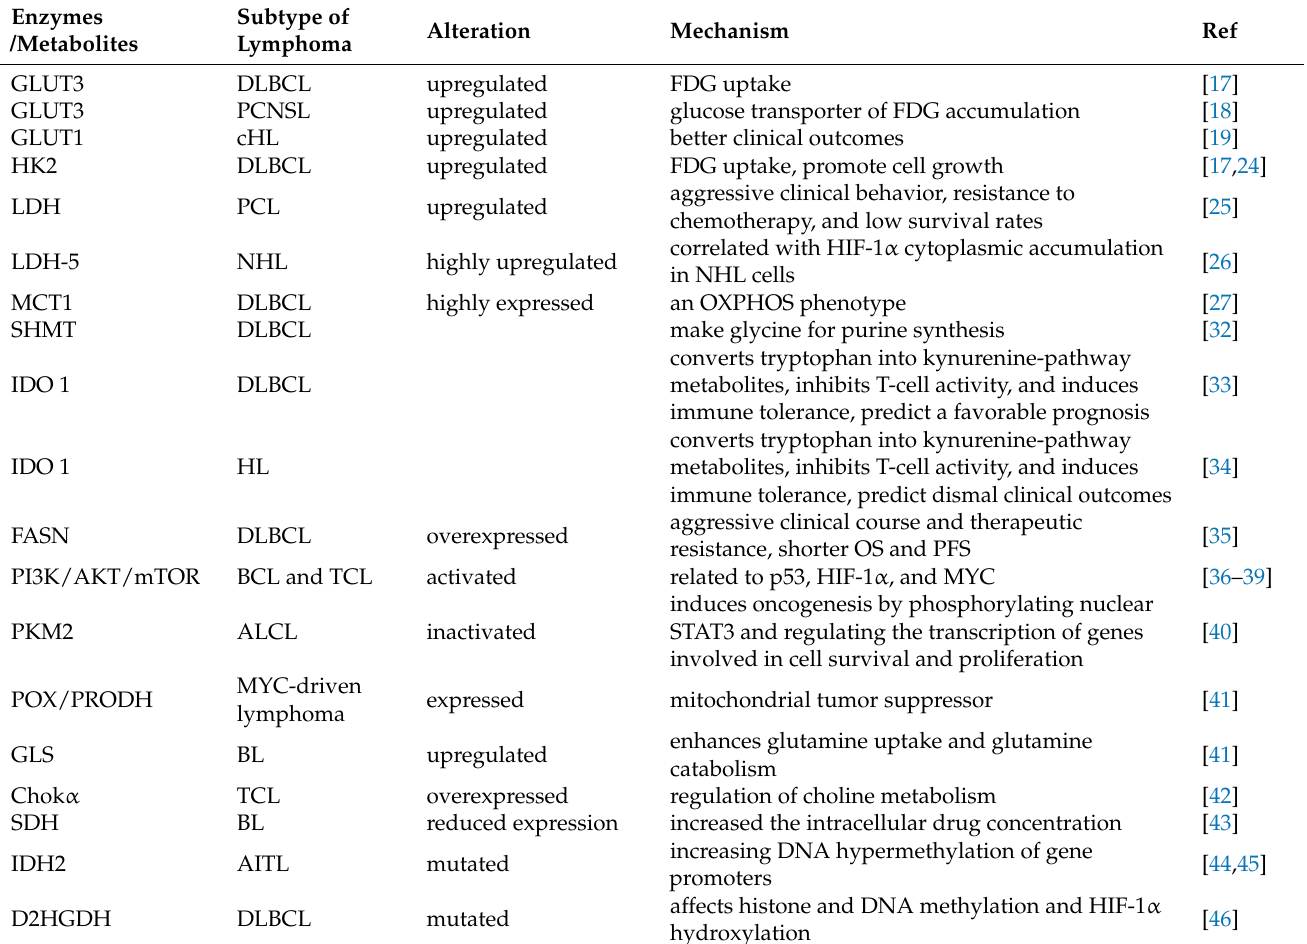
Table 1. Enzymes and metabolite alterations in